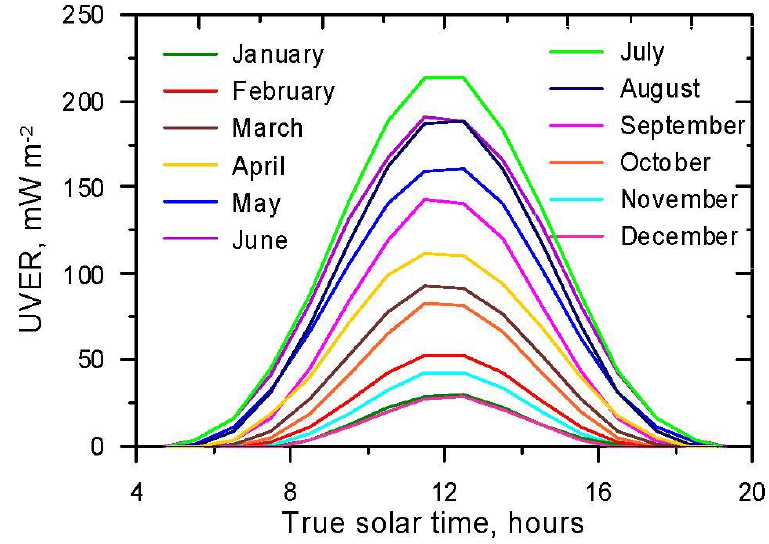
Figure 3. Monthly mean hourly UVER evolution in Valladolid, Spain, (mWm −2 ) for the period 2013– 2019.